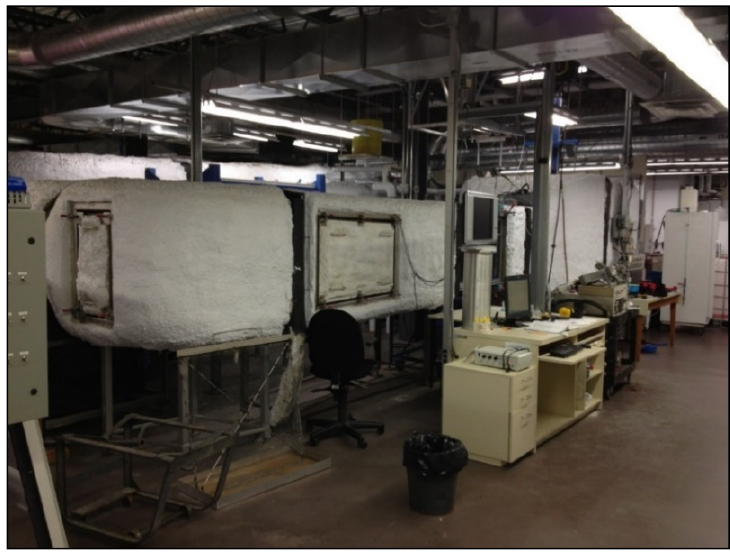
Figure 1. Icing Wind Tunnel.